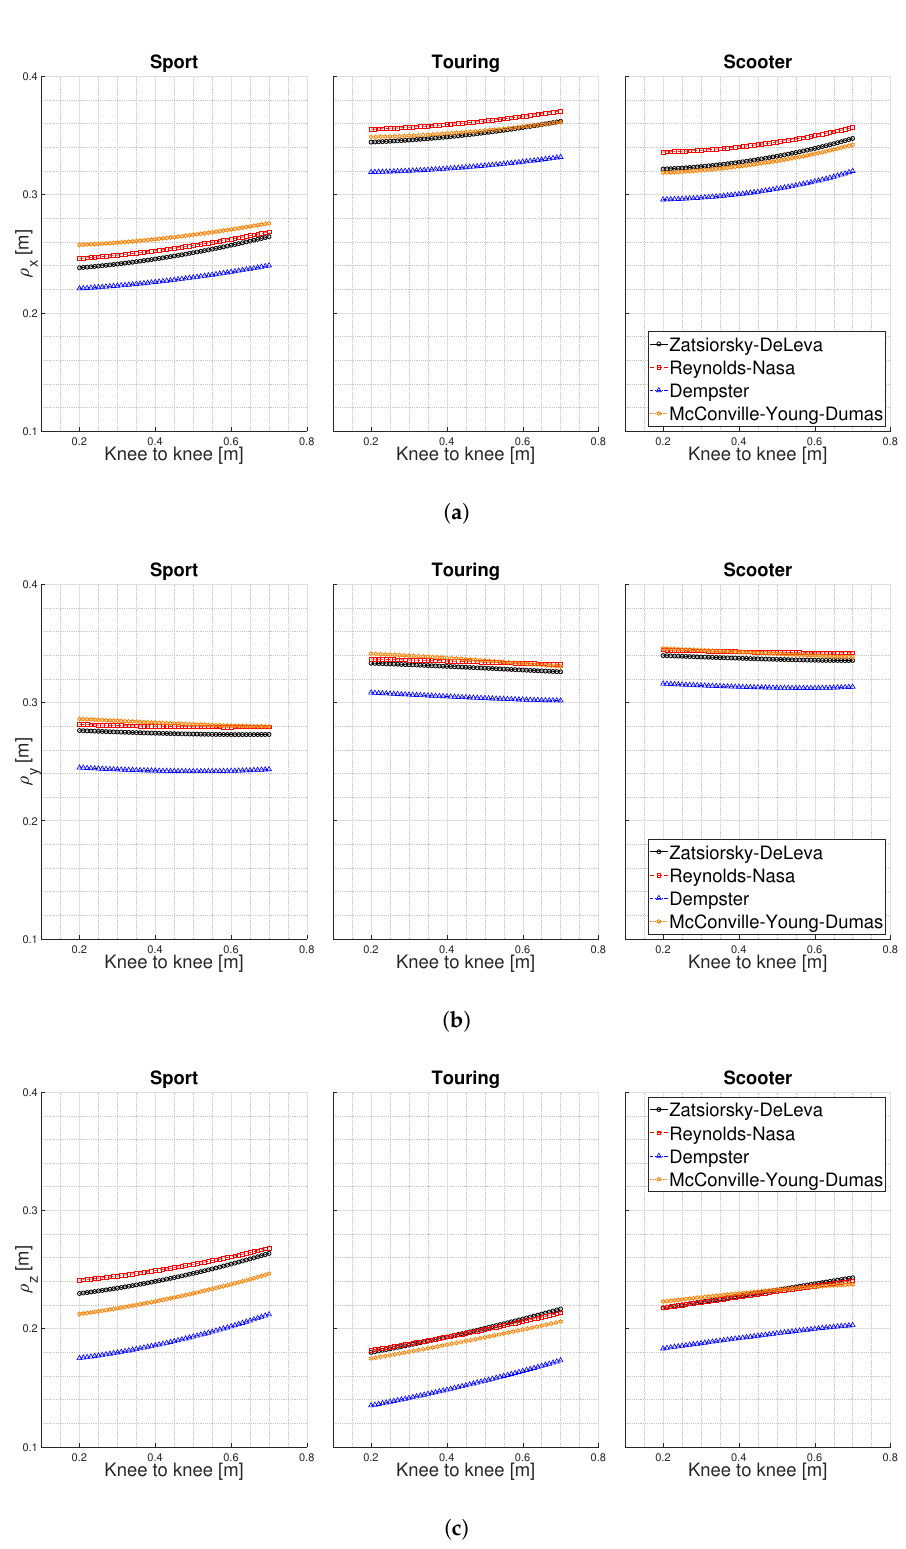
Figure 5. Roll ρ x ( a ), pitch ρ y ( b ), and yaw ρ z ( c ) gyration radii as a function of knee